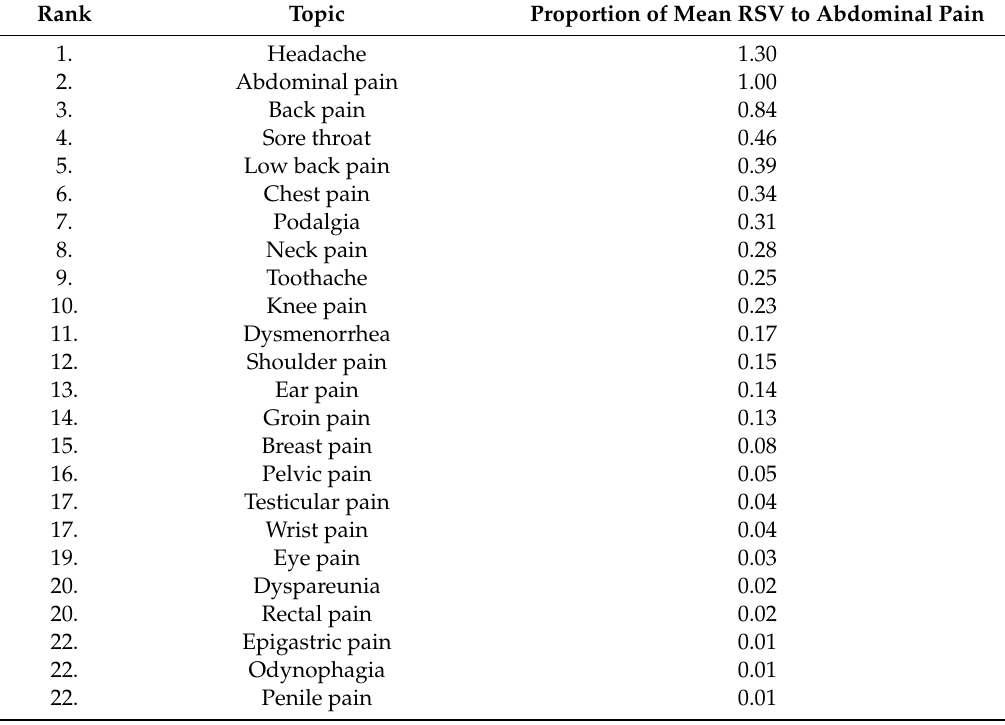
Table 1. Popularity of pain-related topics in proportion to “Abdominal pain” (adjusted data; relative search volume [RSV] over